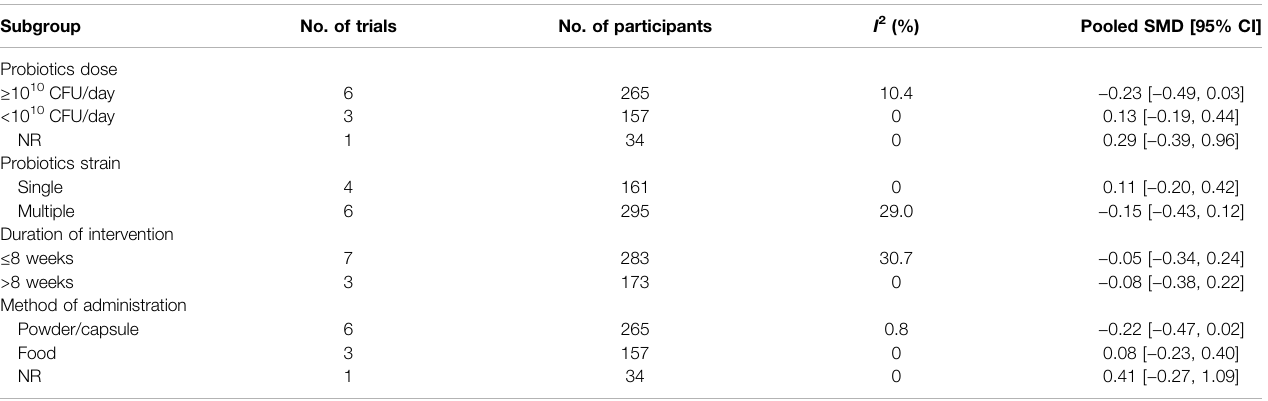
TABLE 3 | Subgroup analysis for the effects of probiotics on IL − 6. Subgroup